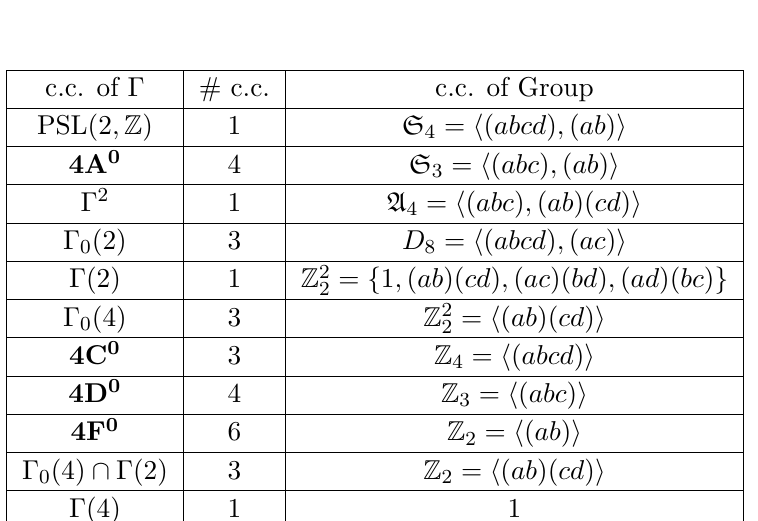
Figure 9 . Diagram of subgroups of S 4 , and equivalently of congruence subgroups that contain (cid:0)(4). The symbols are de(cid:12)ned in the table below, where in each class, we also indicate the number of conjugates. We use the nomenclature of [22] for congruence